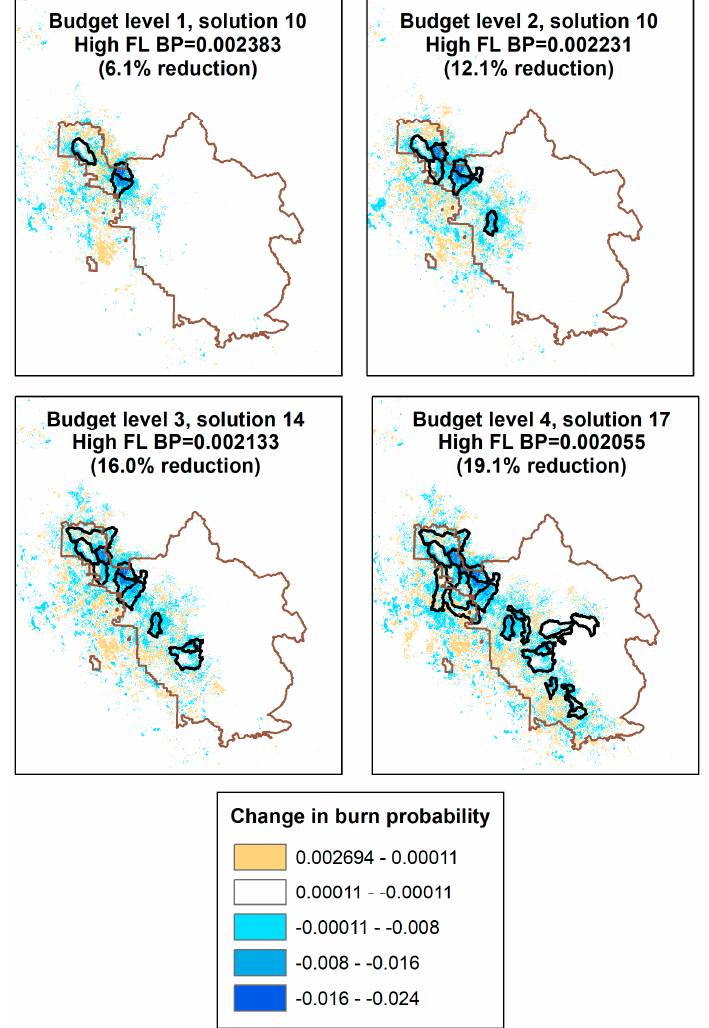
Figure 7. Modeled fuel treatment effect on high flame length burn probabilities (FL BP) in the Sierra National Forest. Blue areas indicate a reduction in burn probability due to treatment, while orange areas indicate a small increase. Black outlines indicate treated PODs.